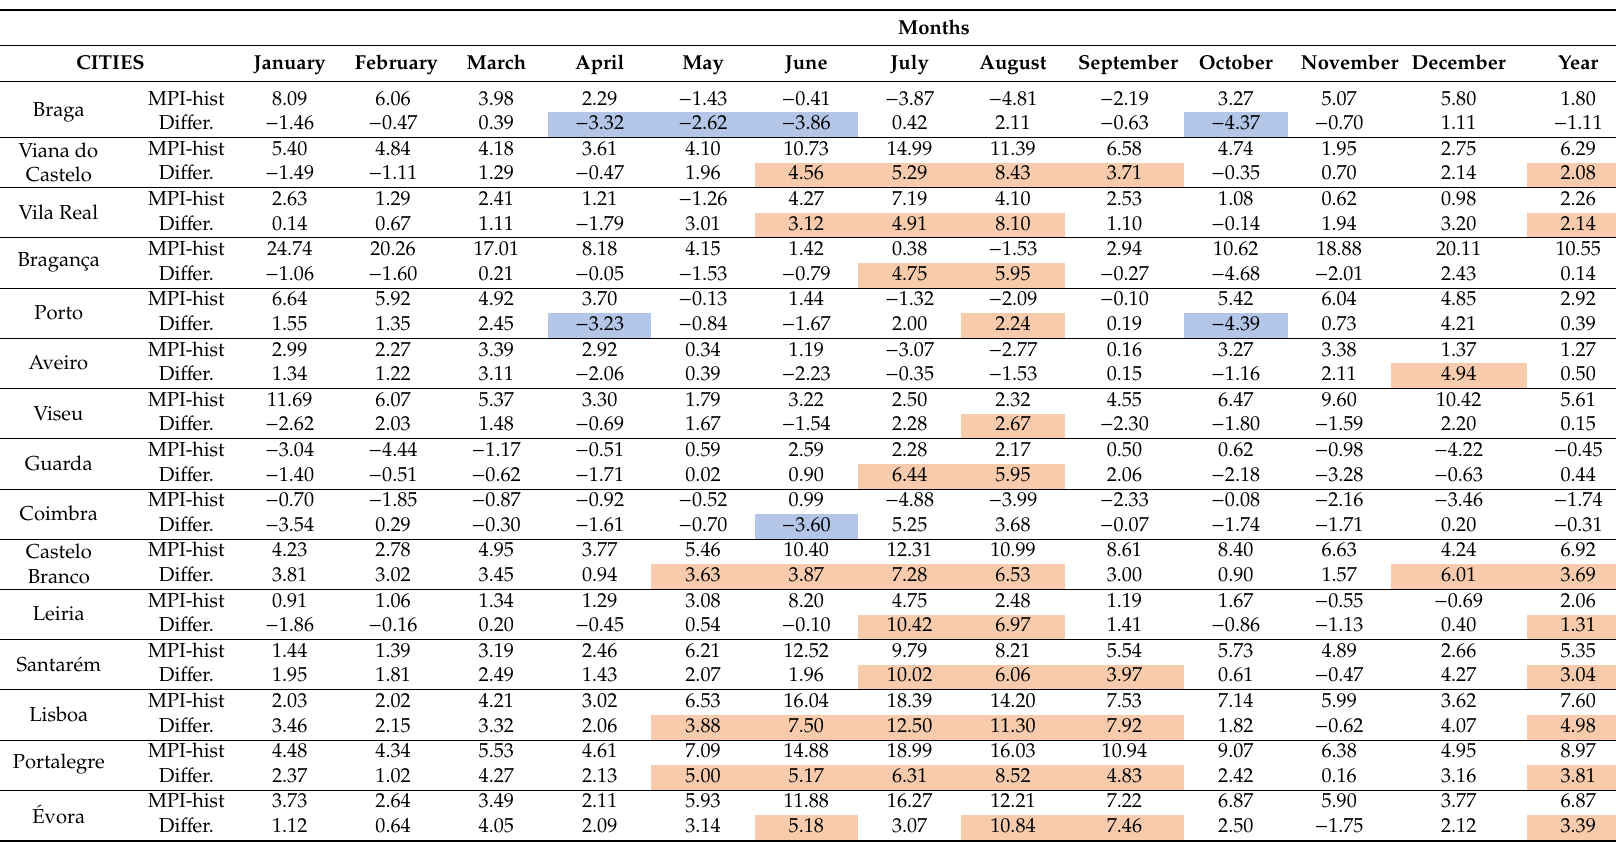
Table 9. Monthly and annual averaged storm-relative helicity (SRH) 0–3 km for each city and the di ff erence between the future and the historical climates. Significant di ff erences ( t -student 5%) are shown in red (positive) and blue